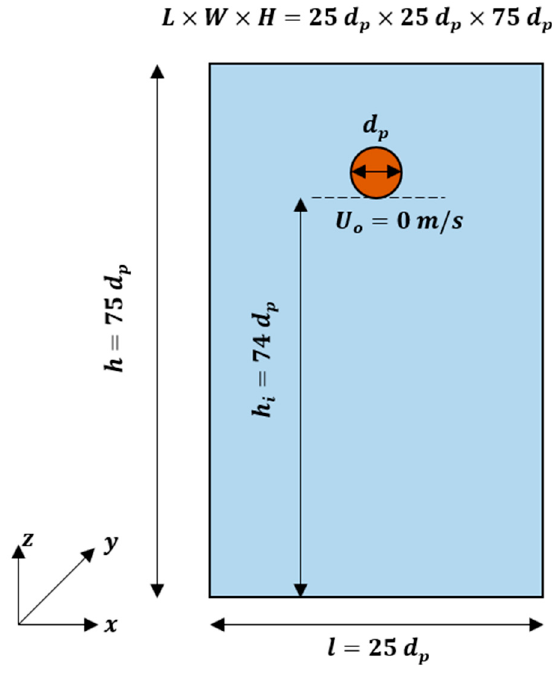
Figure 4. Description of single sphere settling. Table 1. Test cases.